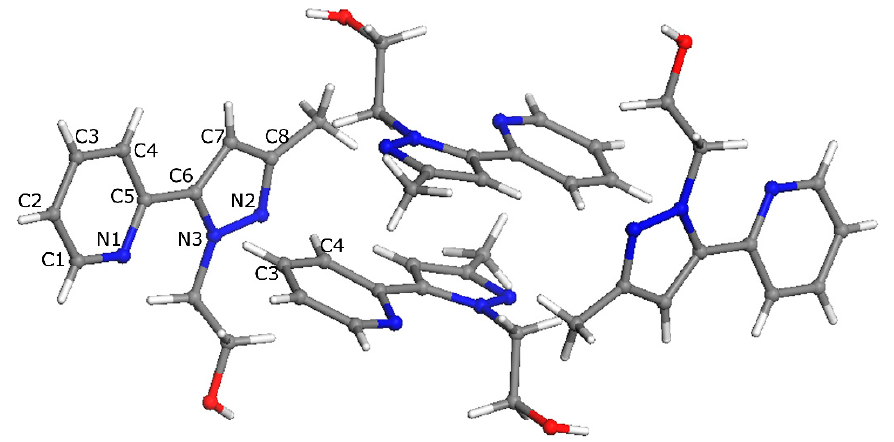
Figure 5. Molecular stacking representation emphasizing π / π interactions between molecules. Atoms colours codes: O (red), N (blue), C (grey) and H (white).